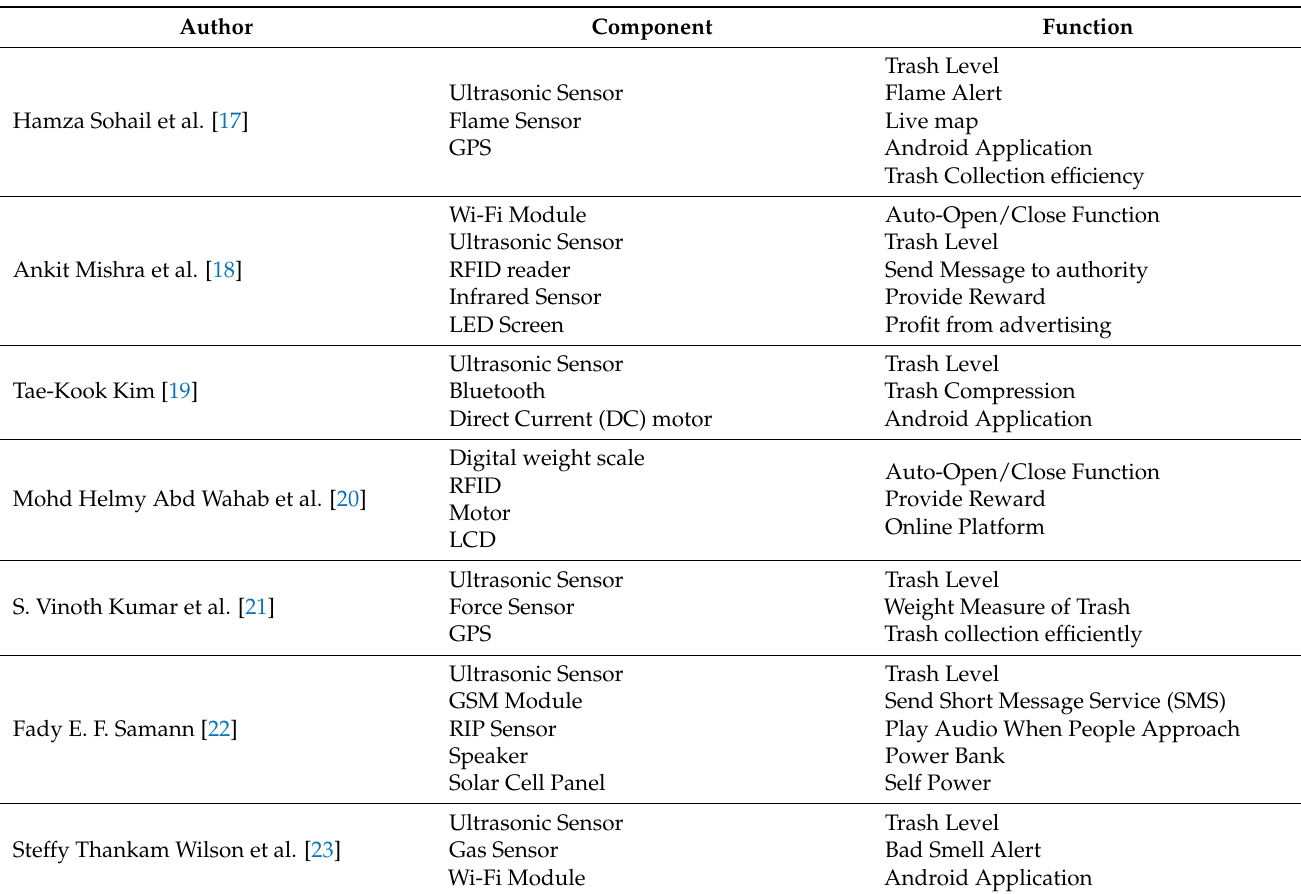
Table 3. Studies Related to Smart Trash Bin Model